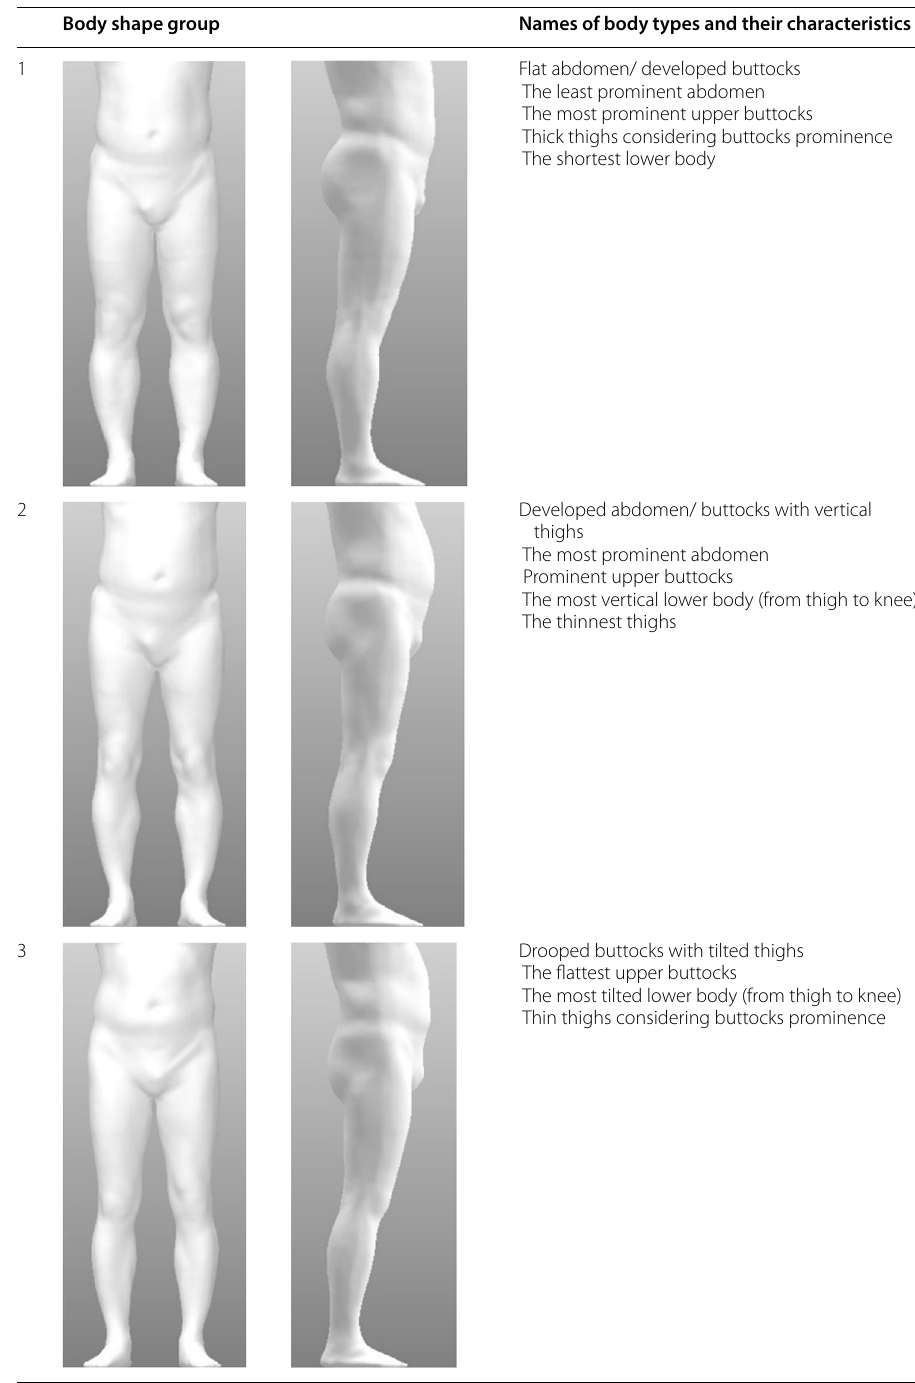
Table 4 Front and side silhouettes of the three body shape groups Body shape group Names of body types and their